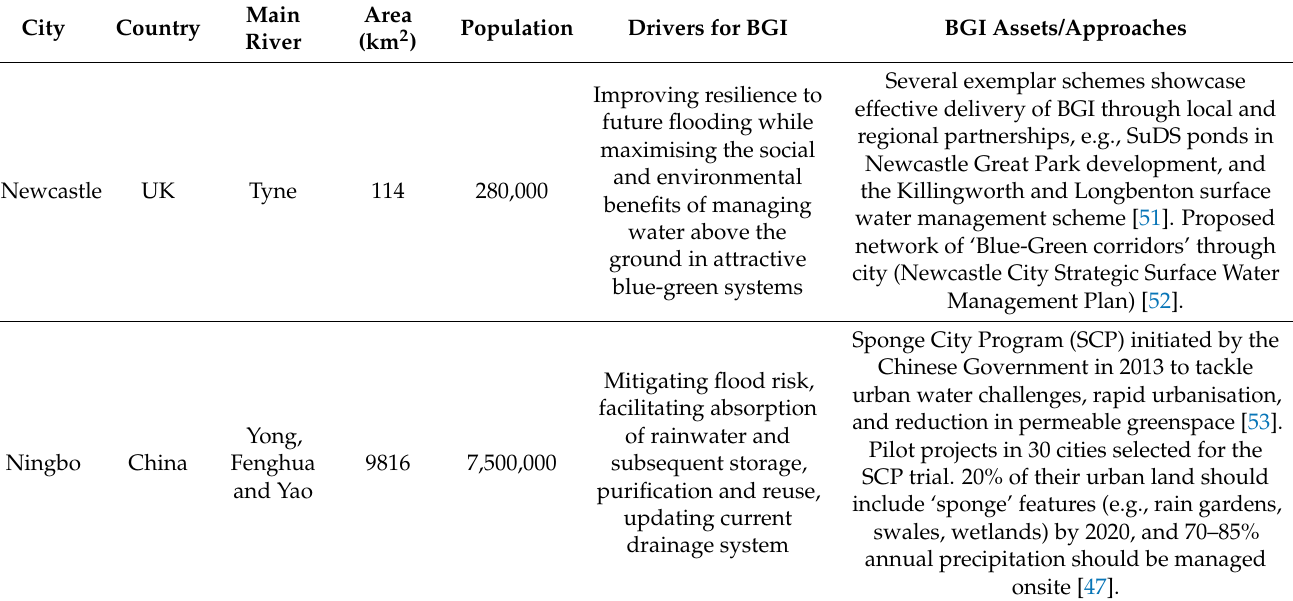
Figure 1. Examples of Blue-Green Infrastructure (BGI) in the case study cities: ( a ) sustainable drainage pond in the Newcastle Great Park development site; ( b ) Ningbo eco-corridor; ( c ) bioswale in a residential area in Portland; ( d ) green tram tracks in central Rotterdam. Photo credits: ( a , b , d ) Emily O’Donnell, ( c ) Noelwah Netusil. Table 1. Background information on the four case study cities. BGI (Blue-Green Infrastructure), SuDS (Sustainable Drainage Systems), CSO (Combined Sewer